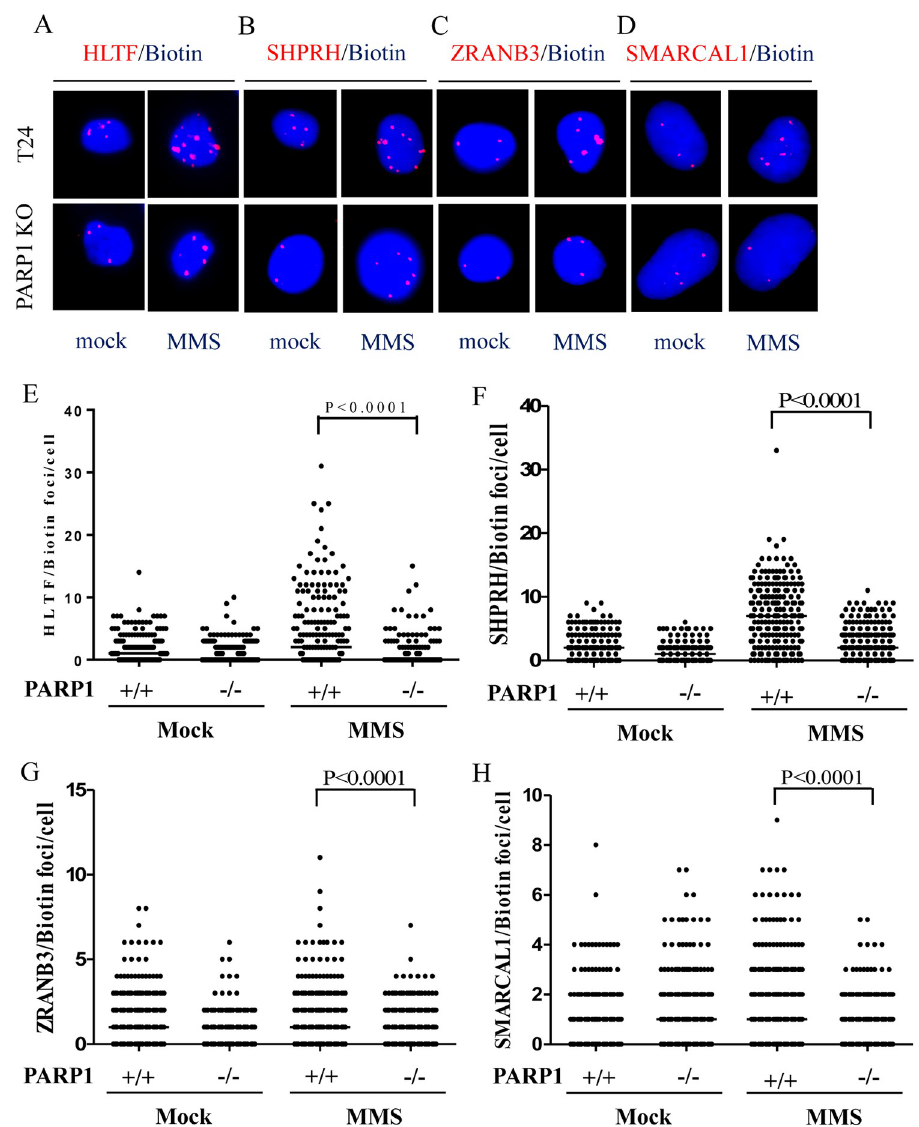
Fig 1. The levels of DNA translocases are reduced at damaged replication forks in PARP1-KO cells. (A)-(D) Representative images of HLTF, SHPRH, ZRANB3, and SMARCAL1 PLA foci, respectively, in wild-type and PARP1-KO T24 cells. Cells were treated with 0.01% MMS for 1 hour. The association of each protein with replication forks was determined by the SIRF assay. (E)-(H) Distributions of HLTF, SHPRH, ZRANB3, and SMARCAL1 PLA foci derived from a-d, respectively. At least 200 cells from each condition were measured. (Raw SIRF data in S1